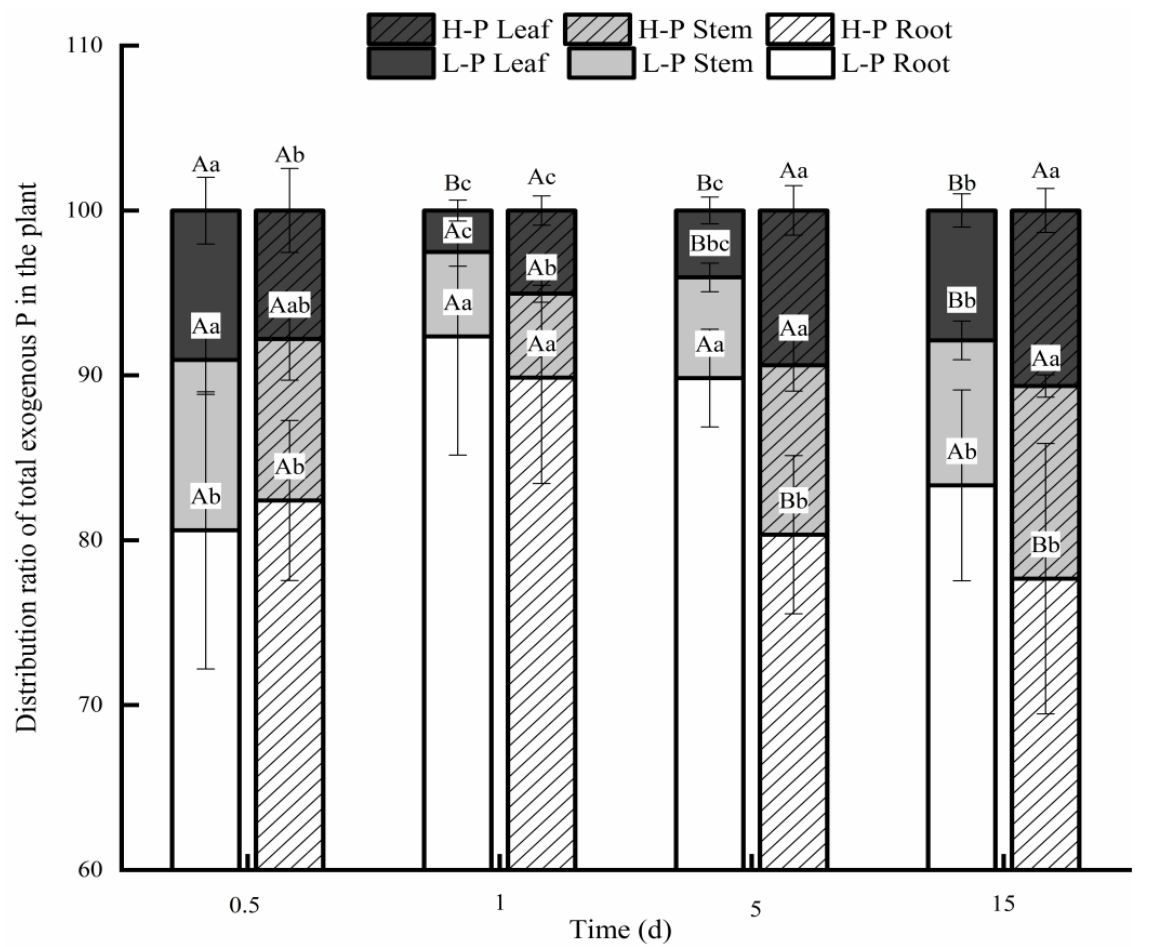
Figure 3. The distribution ratio of exogenous P absorbed in different organs of M1 Chinese fir under different P supply conditions. “L-P” and “H-P” represent the low-P and high-P treatments, respectively. Lowercase letters indicate significant differences ( p < 0.05) at different treatment times under the same P treatment. Uppercase letters indicate significant differences ( p < 0.05) between different treatments at each time point.